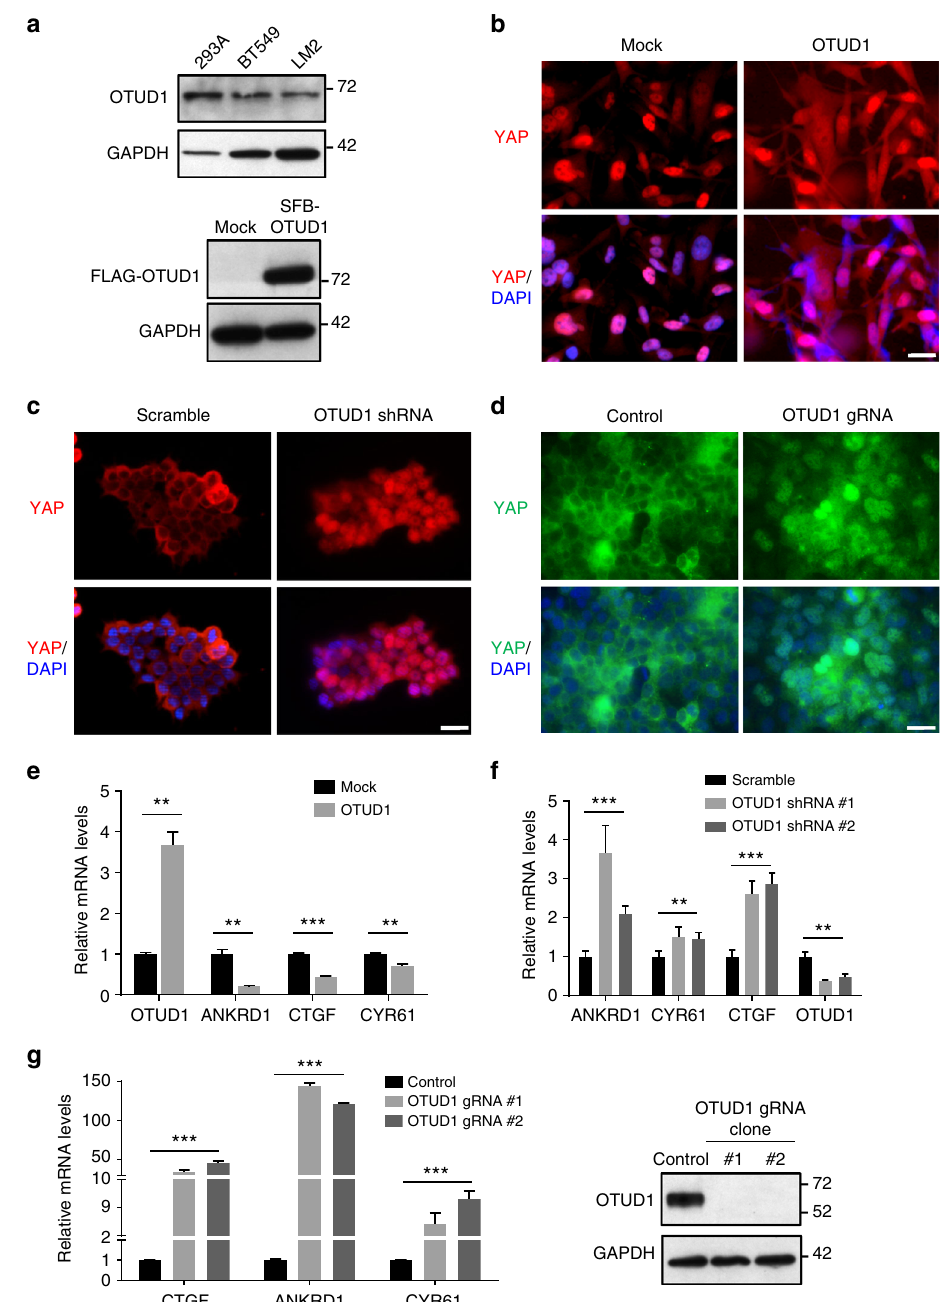
Fig. 5 OTUD1 inhibits nuclear localization and transcriptional activity of YAP. a Upper panel: immunoblotting of OTUD1 and GAPDH in HEK293A, BT549, and LM2 cell lines. Lower panel: immunoblotting of FLAG-OTUD1 and GAPDH in LM2 cells stably transfected with SFB-OTUD1. b LM2 cells stably overexpressing OTUD1 were immunostained with a YAP-speci fi c antibody (red). DAPI (blue) was used to stain DNA. Scale bar, 20 μ m. c , d HEK293A cells expressing OTUD1 shRNA ( c ) or gRNA ( d ) were immunostained with a YAP-speci fi c antibody (red in c ; green in d ). DAPI (blue) was used to stain DNA. Scale bar, 20 μ m. e – g qPCR of ANKRD1 , CTGF , and CYR61 in BT549 cells expressing HA-OTUD1 ( e ) and in HEK293A cells expressing OTUD1 shRNA ( f ) or OTUD1 gRNA ( g , left panel). Right panel in g : immunoblotting of OTUD1 and GAPDH in two independent OTUD1 knockout HEK293A clones generated by CRISPR-Cas9. n = 3 biological replicates. Error bars in e – g are s.e.m. Statistical signi fi cance was determined by a two-tailed, unpaired Student ’ s t -test. * P < 0.05; ** P < 0.01; *** P <